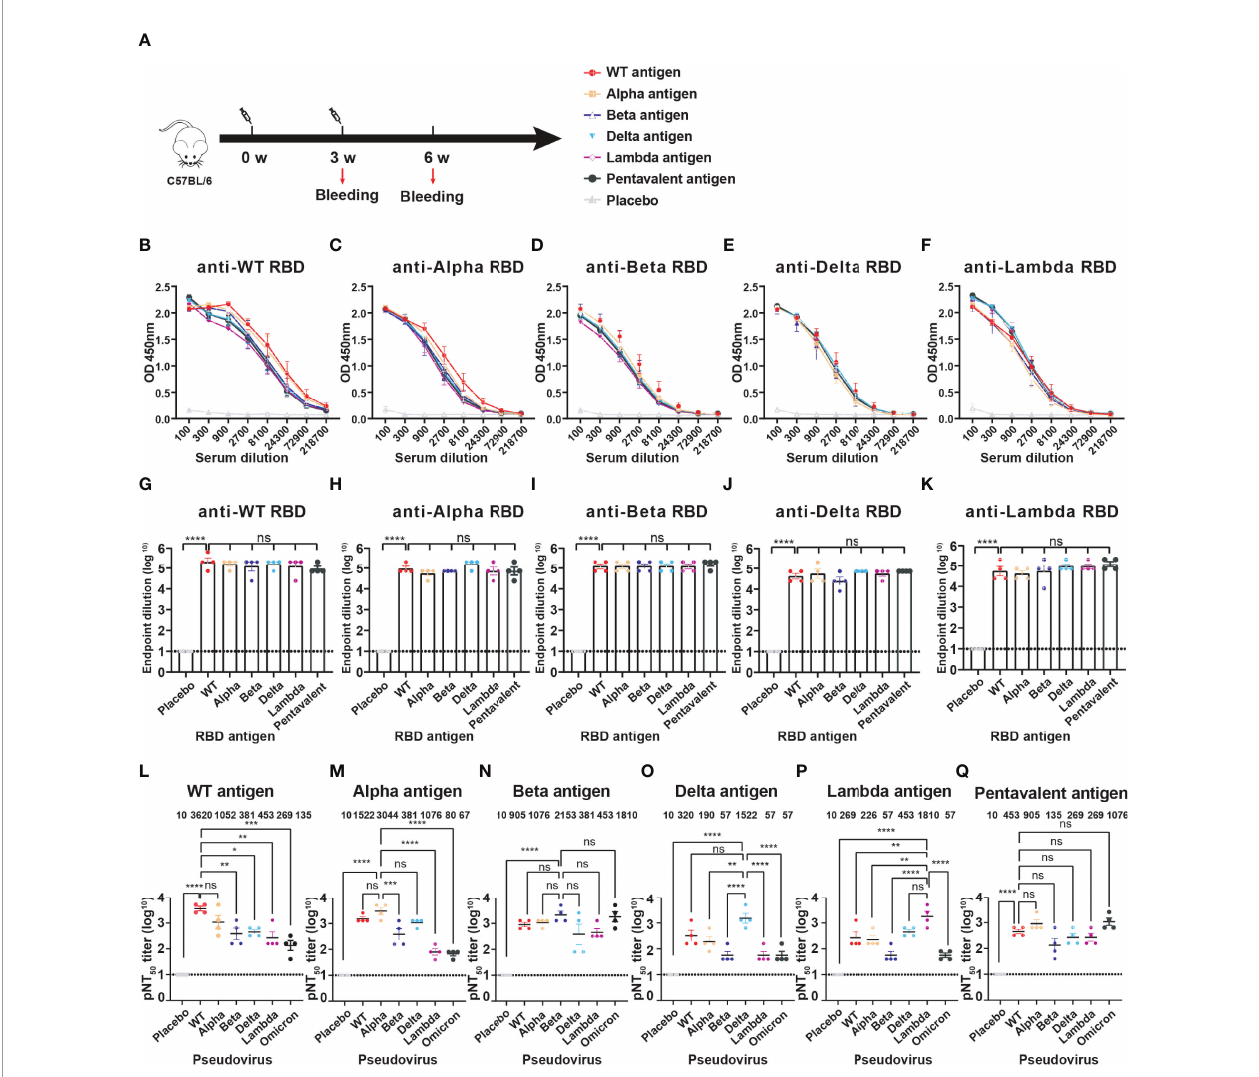
FIGURE 3 | The cross-immunity evaluation of different variant RBD antigens. (A) The diagram of the immune program of monovalent and multivalent RBD antigens. Naive C57BL/6 mice (n = 4) were muscularly immunized and bled at the indicated time points. The immune dose is 10 m g per mouse of each variant RBD protein; Pentavalent RBD antigens was a mixture of 2 m g each variant RBD protein. Mice immunized with PBS de fi ned as placebo control. (B – F) Detection of the speci fi c IgG against different SARS-CoV-2 variant RBDs by ELISA. Serum samples were collected after 3-week boost immunization. A placebo formulation was given as the control. (G – K) The endpoint dilution titers of anti-different variant RBD antibodies induced by different monovalent and pentavalent RBD antigens. (L – Q) Neutralizing titers of different variant RBD antigens against different variant pseudoviruses. The data are shown as the mean ± SEM. The dotted horizontal lines indicate the limits of quanti fi cation for endpoint dilution and NT 50 titers. P values were determined by one-way ANOVA (ns, p > 0.05; *p < 0.05; **p < 0.01; ***p < 0.001; ****p <